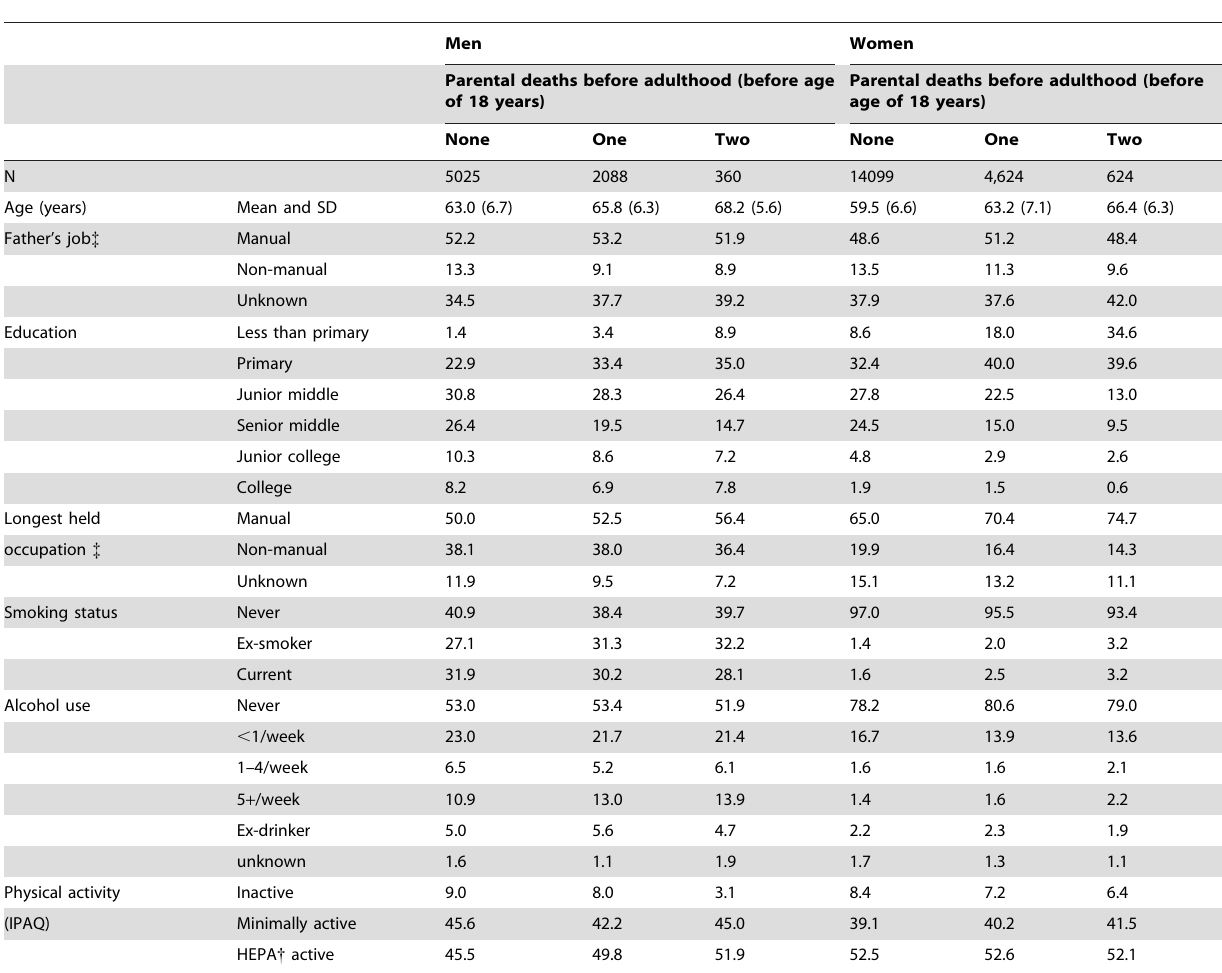
Table 1. Characteristics by early life parental death in 26,820 older Chinese men and women in recruitment phases 1, 2 and 3 of The Guangzhou Biobank Cohort Study